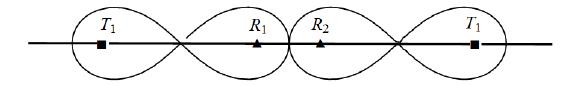
Figure A4. Maximum placement intervals of homogeneous BR sequence 1